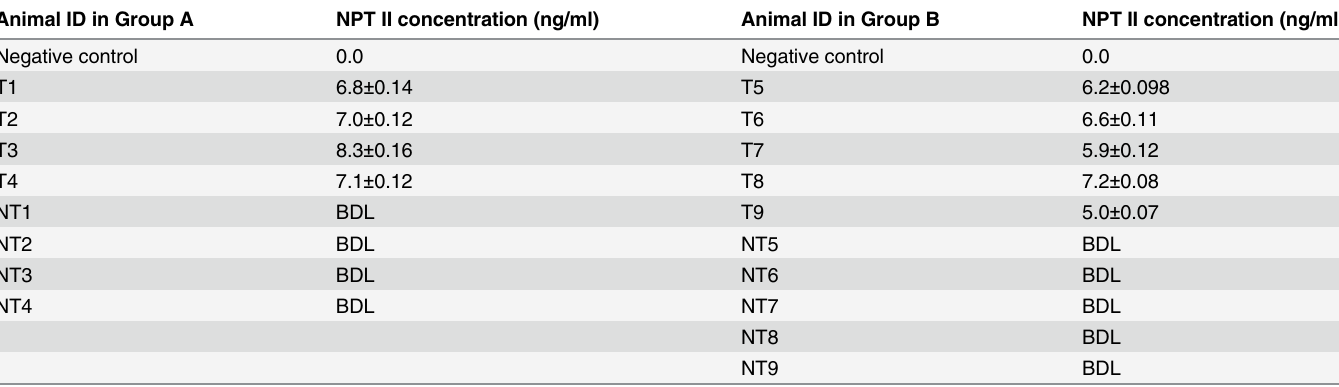
Table 1. NPT II concentration in intestinal fecal samples collected from transgenic and non-transgenic pigs measured by ELISA. Animal ID in Group